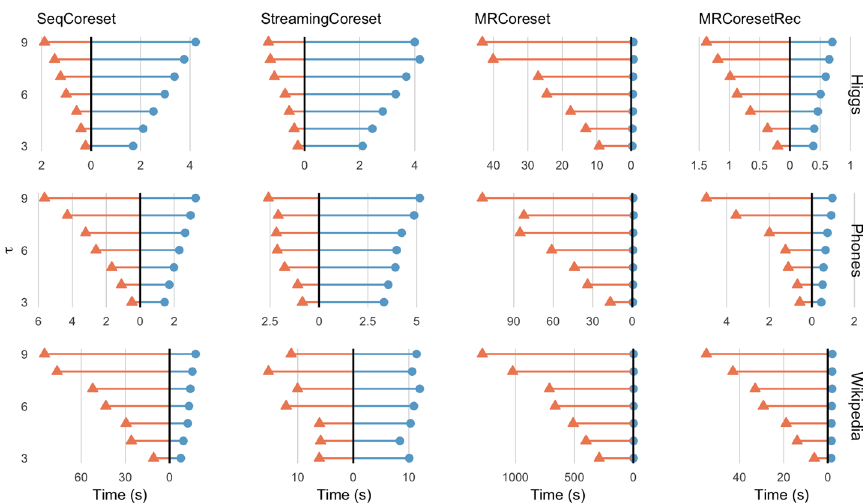
Fig. 5 Time spent building the coreset and time spent computing the solution. To the left the time for the solution , to the right the time for the coreset . The x axis reports the running time (in seconds), the y axis reports the values of